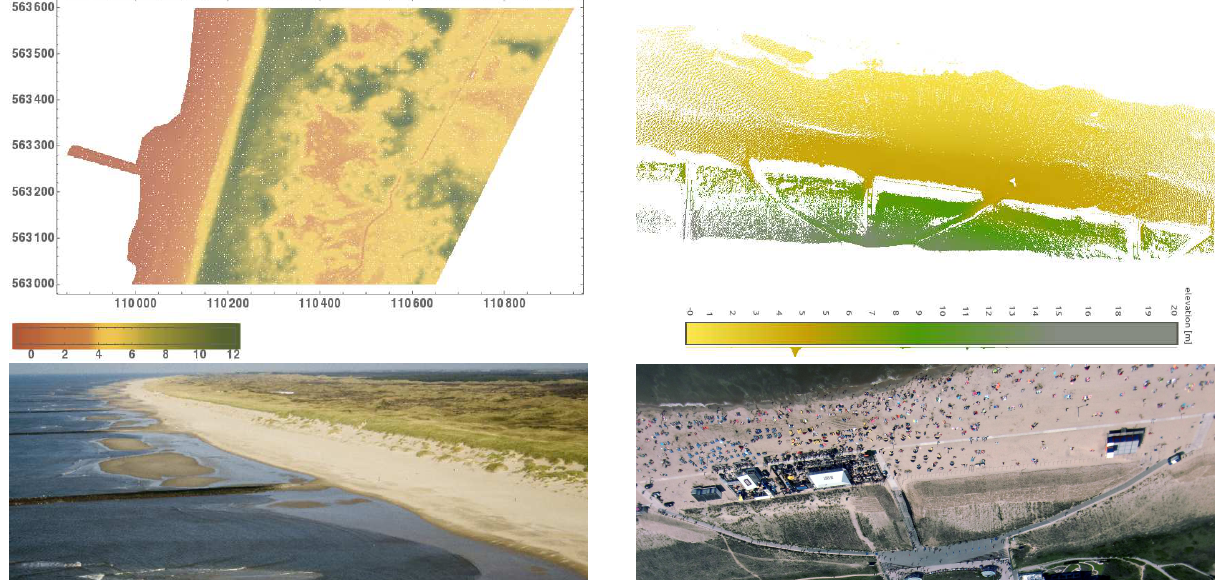
Figure 2. (Top) One epoch of topographic data, for ALS-TEXEL (left) and PLS-KIJKDUIN (right). In the left image, the sea is to the left, and a large part of the dunes is visible in yellow and green colors. Within the dunes, a North-South oriented path is visible In the right image, the sea is at the top, the beach is shown in blue, while a strip of dunes is represented in green and yellow colors. Different access paths through the dunes to the beach are visible as well. (Bottom) Photo impressions, Texel, left, and Kijkduin, right. (Photo sources: Rijkswaterstaat, Wikipedia)